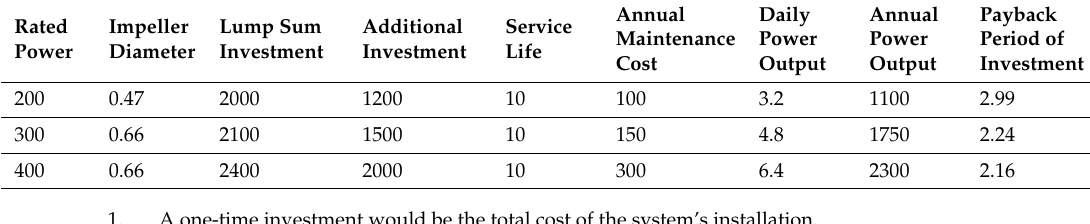
Table 12. Economic benefit calculation for piston wind power generation for an auxiliary lighting